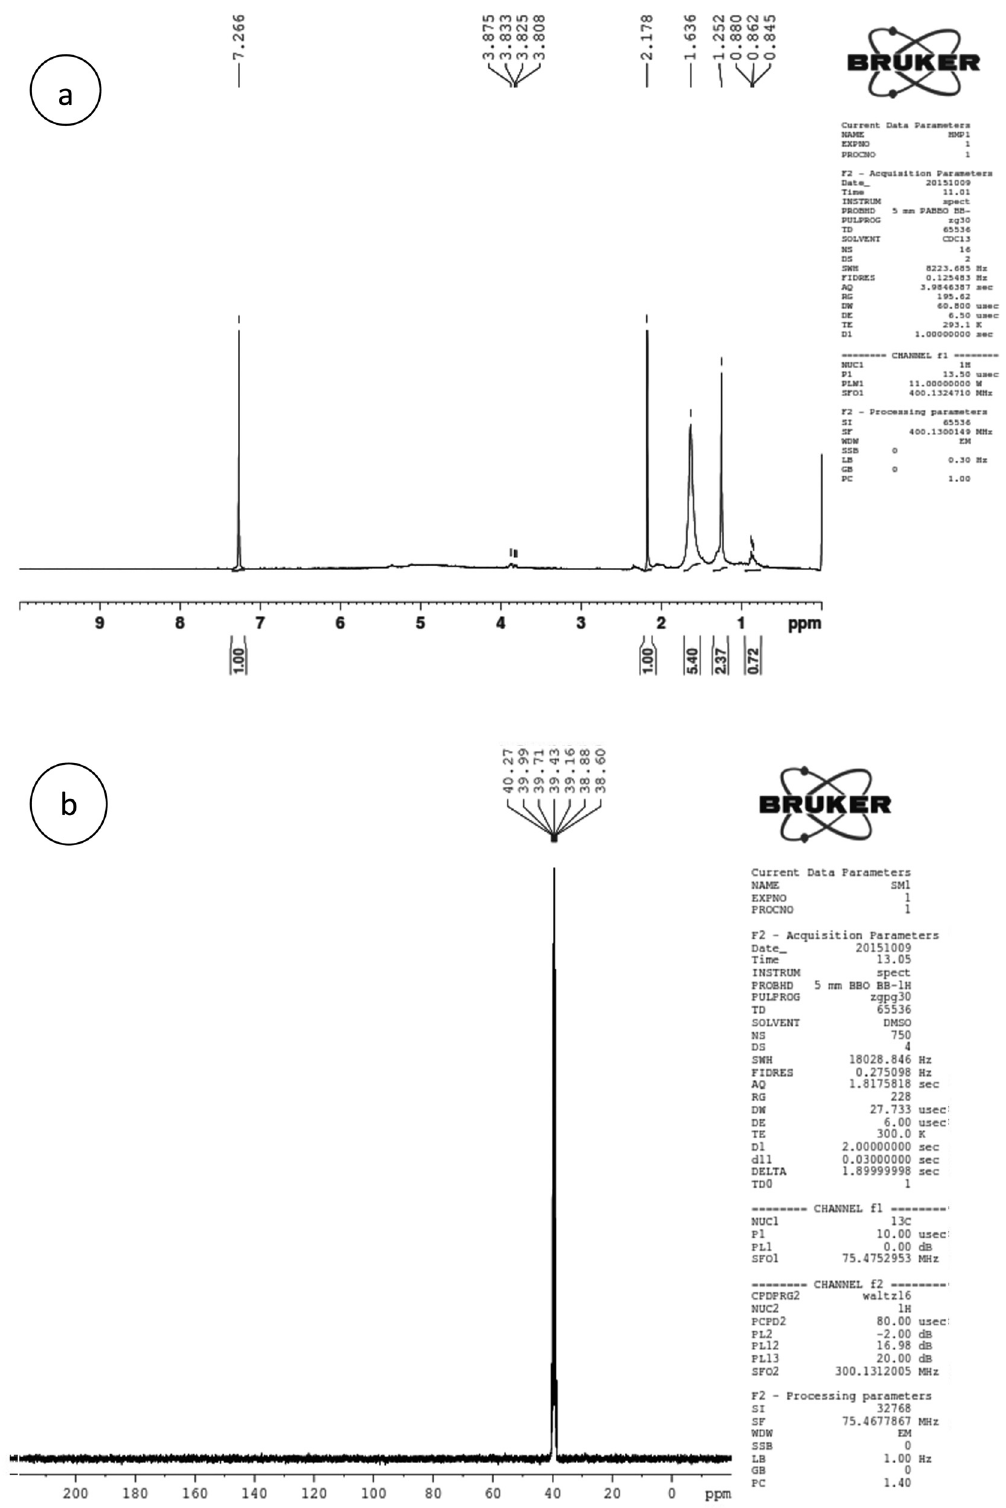
Figure 2: NMR spectrum obtained from aqueous leaf extract of A. monophylla : ( a ) 1 H NMR and ( b ) 13 C